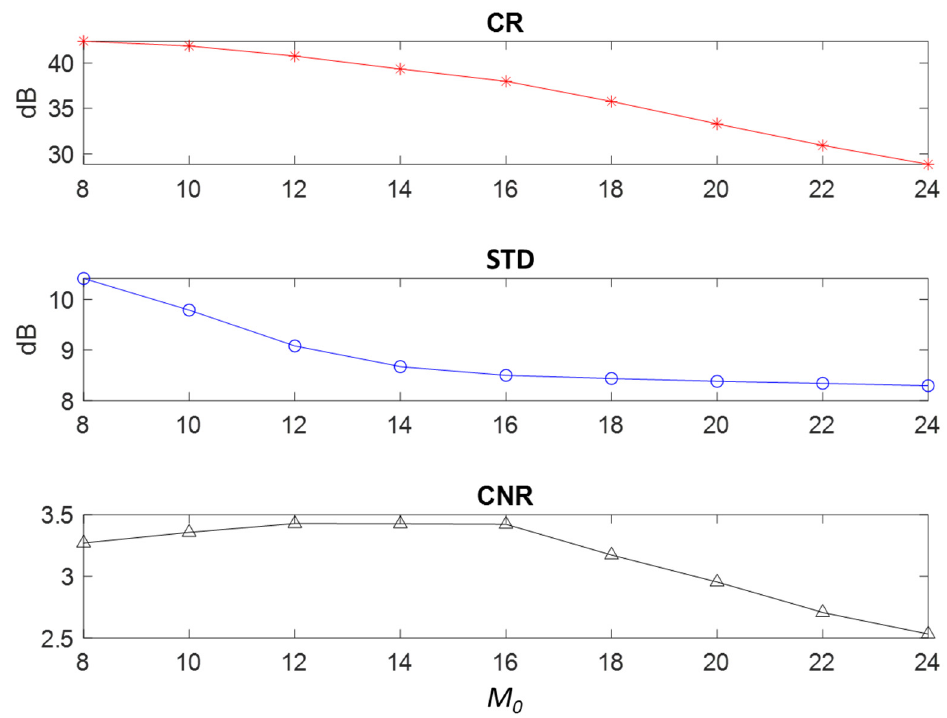
Figure 3. Quantitative analysis of contrast ratio (CR), standard deviation (STD) and contrast-to-noise ratio (CNR) as a function of M 0 .